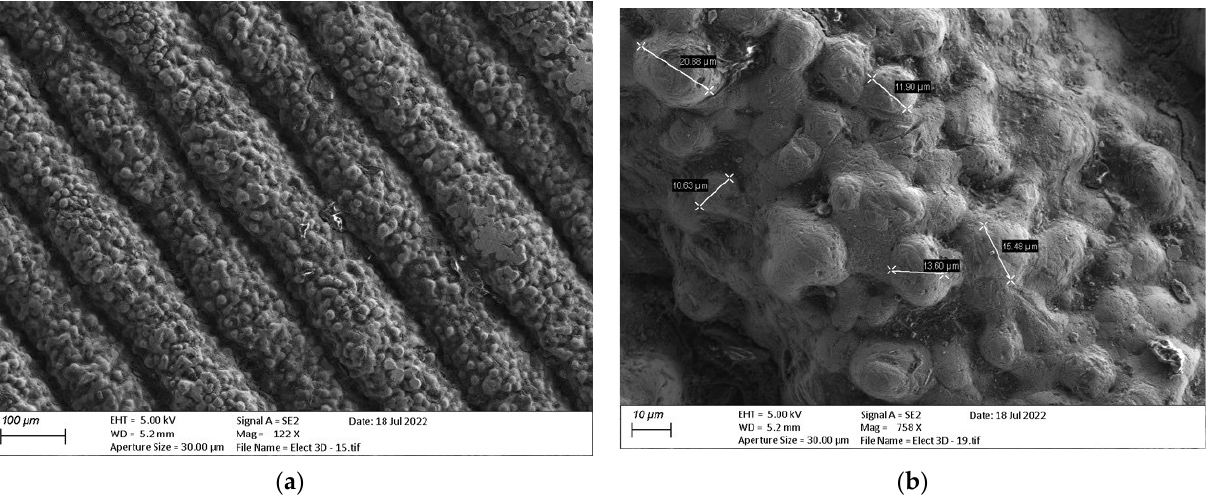
Figure 14. SEM images of ADAM copper electrode: ( a ) Lateral surface with layered and granulated structure (122× amplification factor); ( b ) Amplified (758×) lateral surface with particle size measurements.